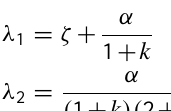
distribution function